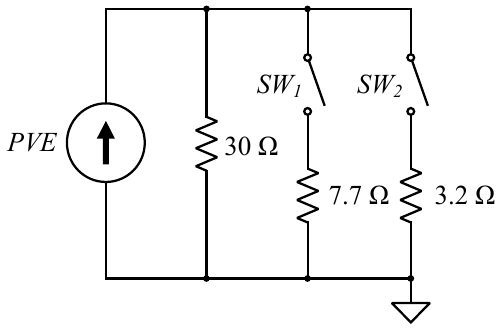
Figure 16. Experimental results with different values of R s,add and the ( a ) I–V curve; ( b ) P–V curve.